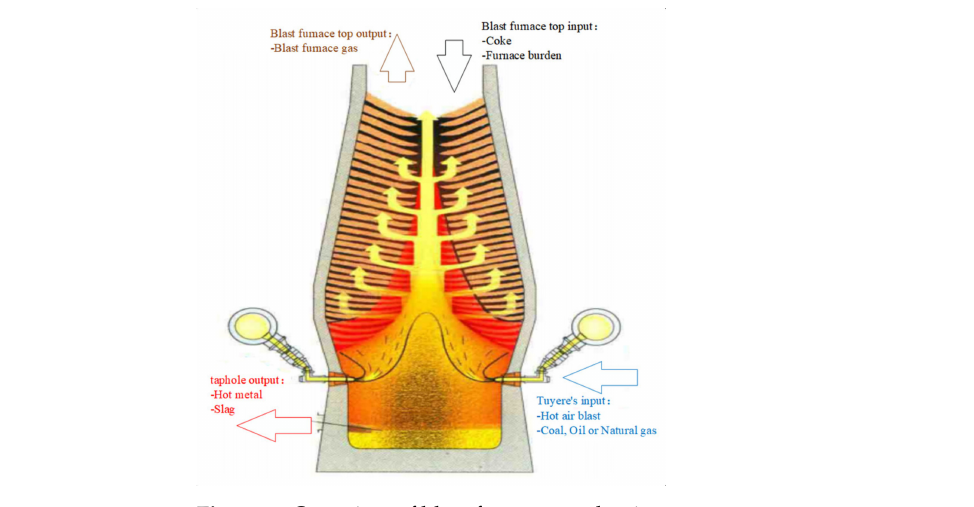
Figure 1. Overview of blast furnace